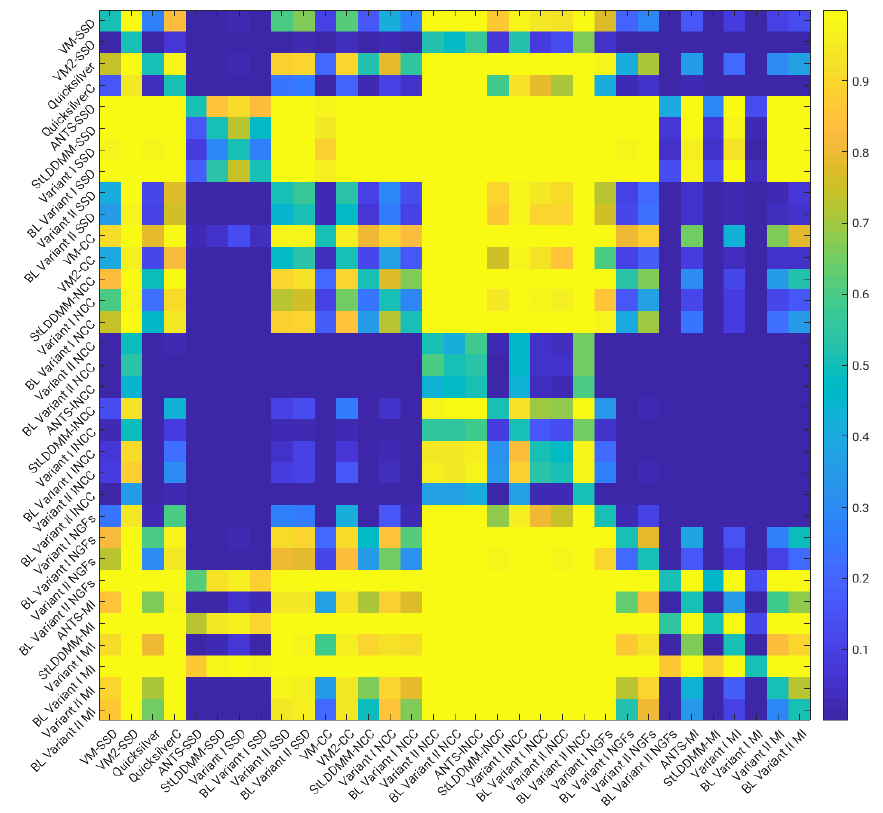
Figure 3. NIREP16. Multi-resolution experiments and Gauss–Newton–Krylov optimization. Results of the pairwise right-tailed Wilcoxon rank-sum tests.